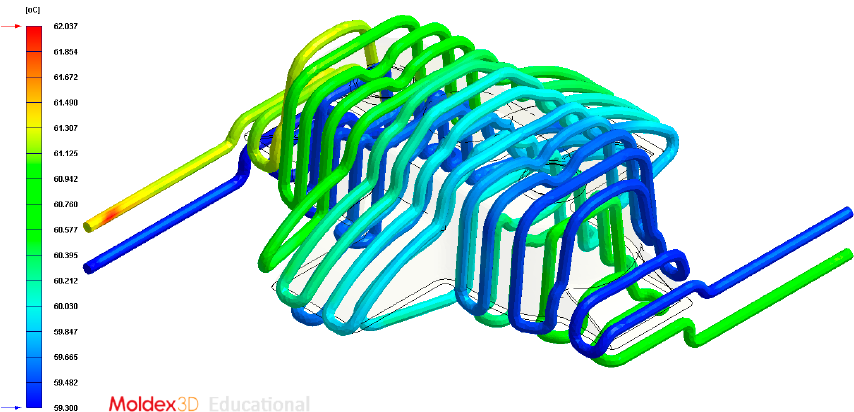
◦ C) of the coolant along the conformal cooling system, Case Figure 16. Temperatures (°C) of the coolant along the conformal cooling system, Case A. Figure 16. Temperatures ( Figure 16. Temperatures (°C) of the coolant along the conformal cooling system, Case A. Figure 16. Temperatures (°C) of the coolant along the conformal cooling system, Case A.